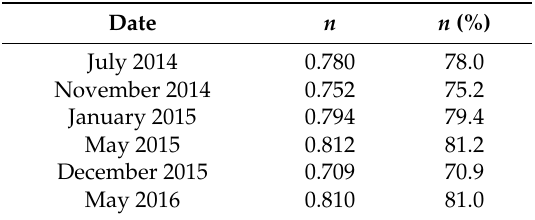
Table 3. Values of n as percentage contribution of the Pertuso Spring groundwater to total discharge measured at the SW_02 gauging station.